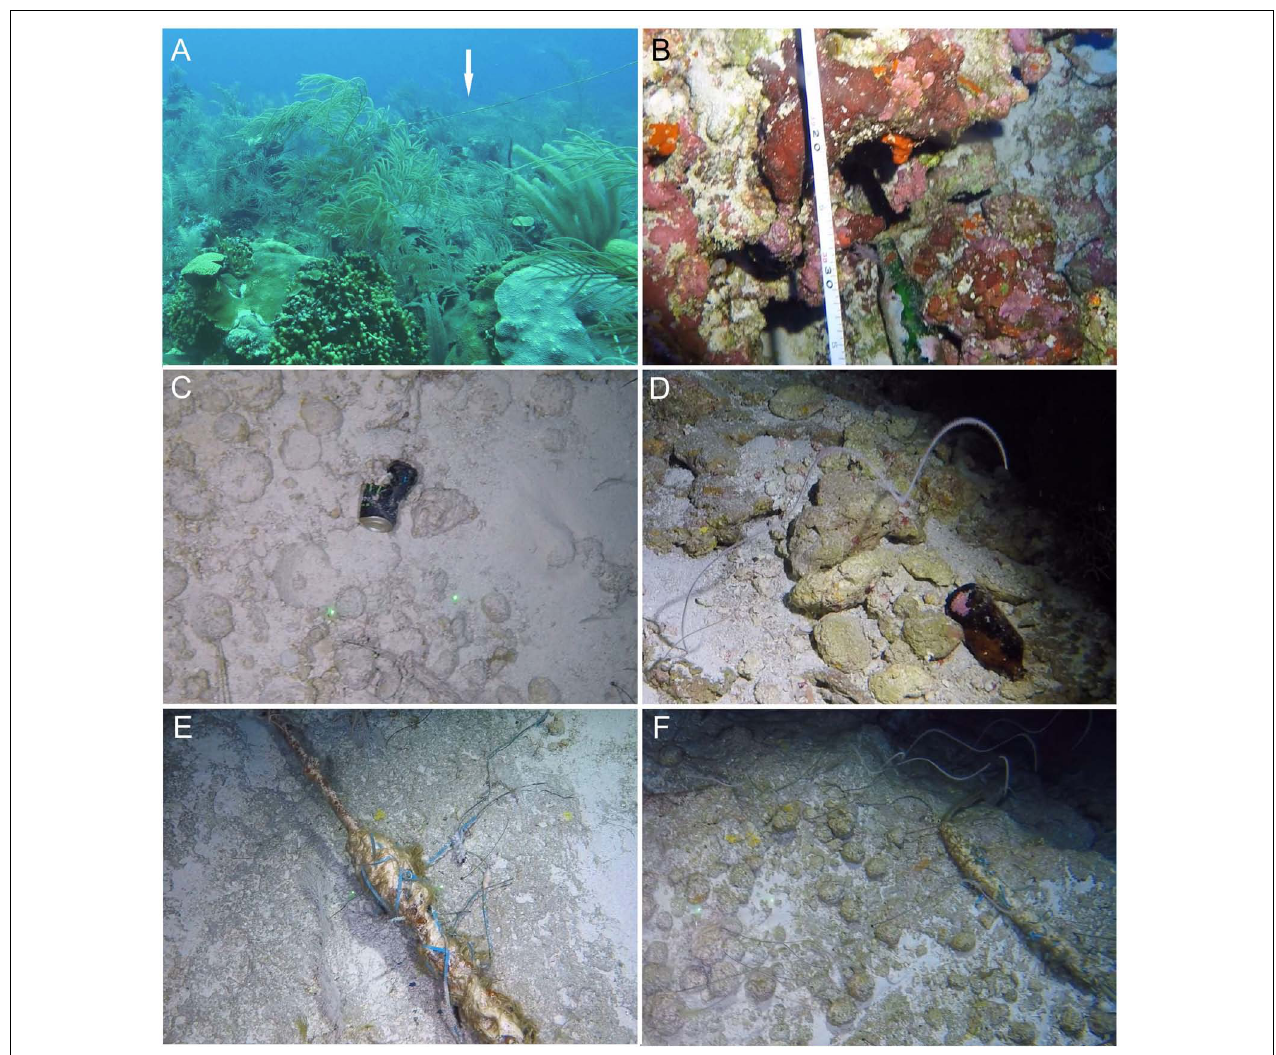
FIGURE 7 | Examples of benthic debris observed on Bermuda’s reefs. (A) Fishing gear (Spittal, 30 m), (B) Glass bottle (Tiger, 93 m), (C) Aluminum can (Tiger, 200 m), (D) Glass bottle (Tiger, 100 m), (E) Fishing gear (Plantagenet Bank, 250 m), (F) Fishing gear (Plantagenet Bank, 187 m). Image credits (A–F) : PV Stefanoudis and M Rivers, Nekton